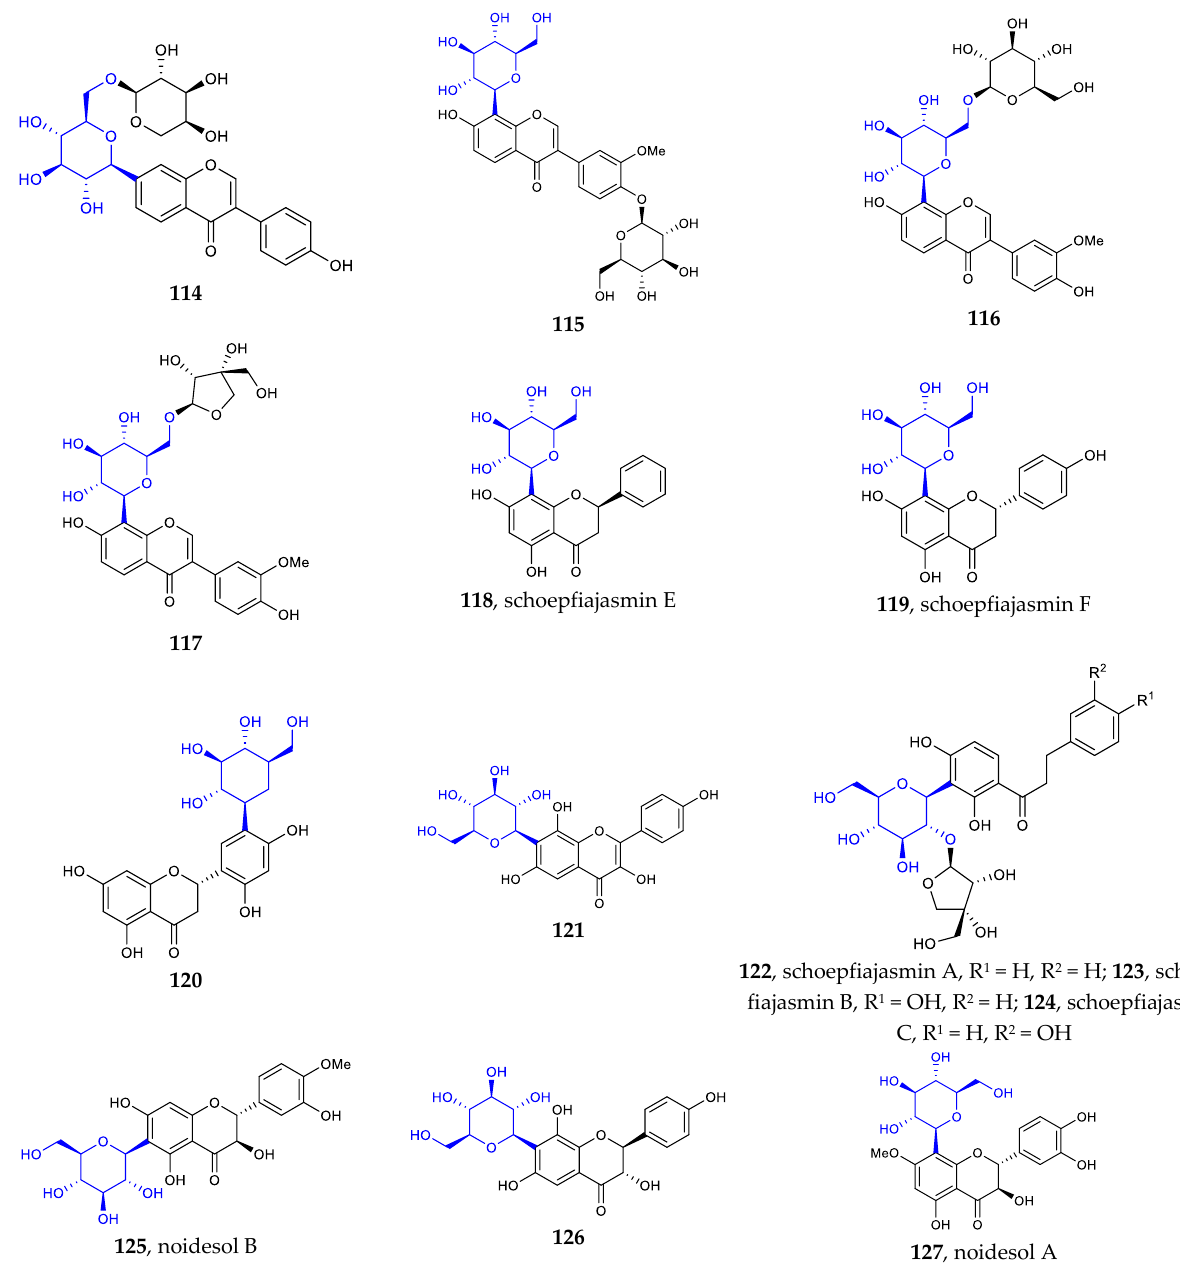
Figure 3. Chemical structures of isoflavone C - β -D-glycosides ( 114 – 117 ), flavanone C -glycosides ( 118 – 120 ), flavonol C -glycoside 121 , dihydrochalcone C -glycosides ( 122 – 124 ), and flavanonol C -glycosides ( 125 – 127 ).